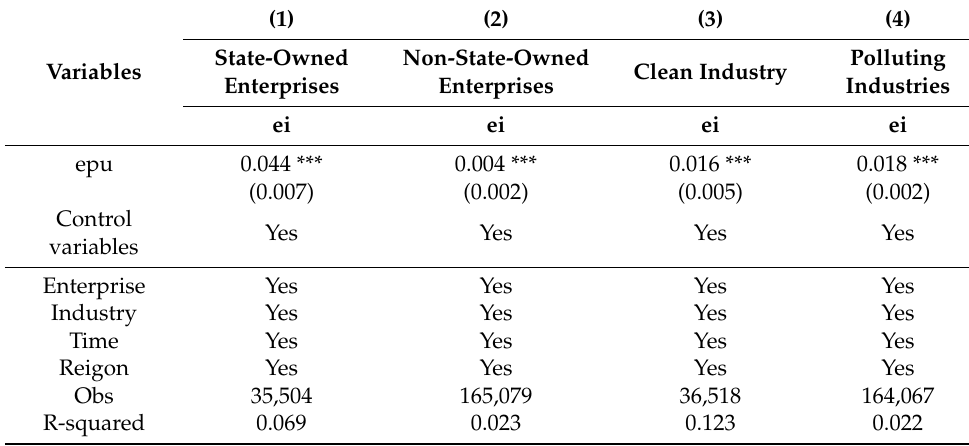
Table 5. Results of enterprise ownership and industry category